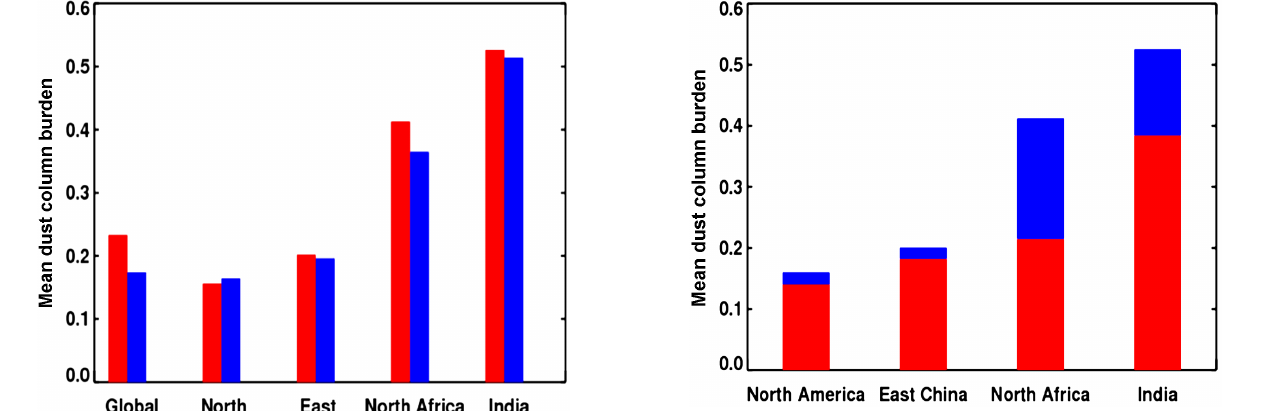
Figure 5. Mean anthropogenic (red) and natural (blue) dust column burdens (gm − 2 ) from mixed dust regions in the four geographical semi-arid regions. Table 1. Mean dust column burdens (gm − 2 ) in four geographical semi-arid regions. Region Anthropogenic